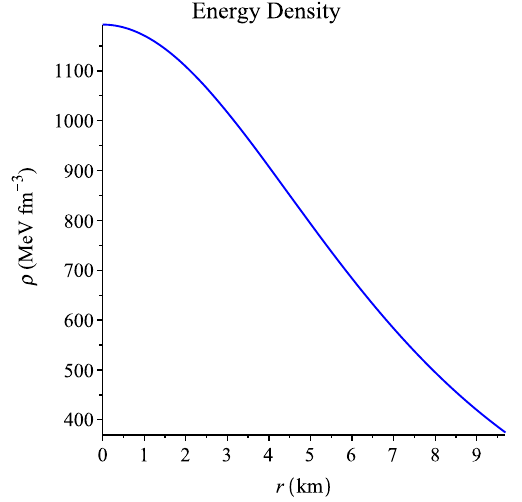
Fig. 2 Plot of energy density ρ in MeV fm − 3 for the parameter values used in Fig. 1